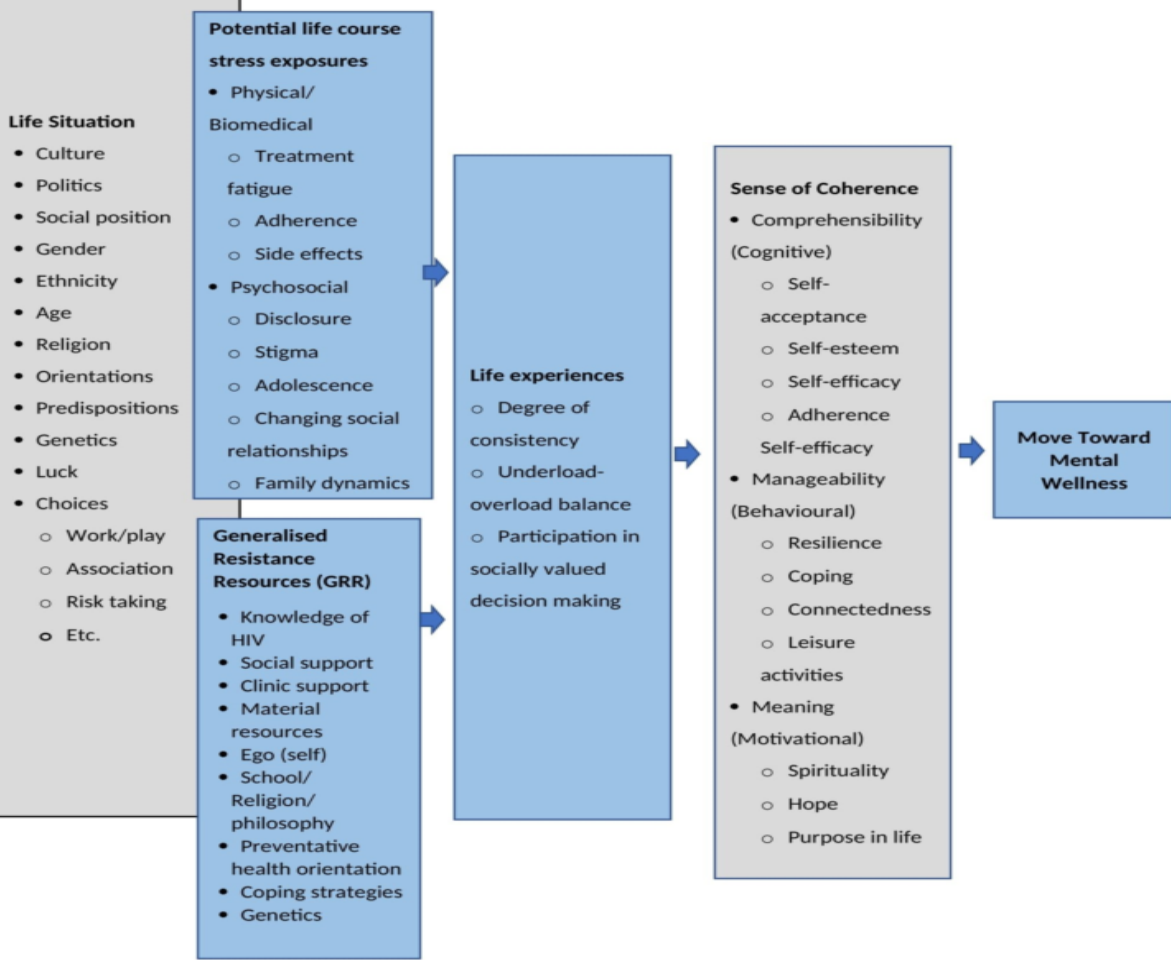
Figure 1. Salutogenic Model of Mental Wellness.